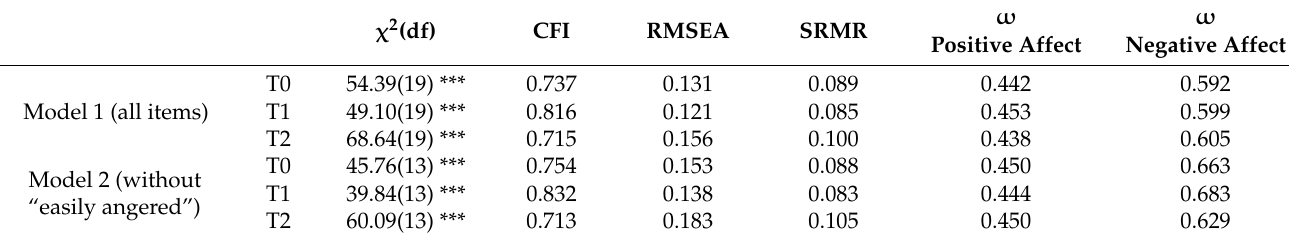
Table 1. Fit measures and McDonald’s omega for the VAS variables positive and negative